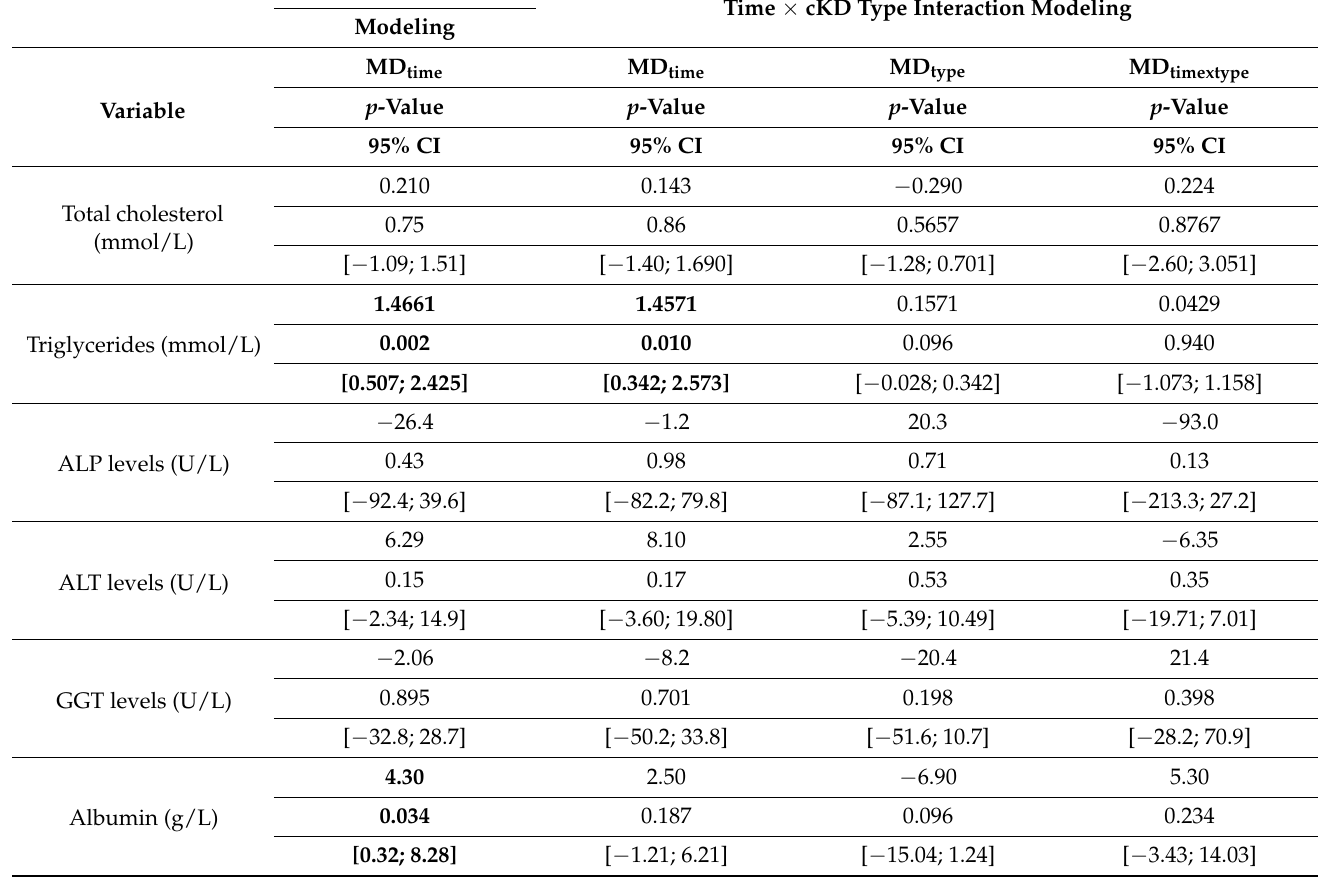
Table 3. Generalized estimating equation modeling.